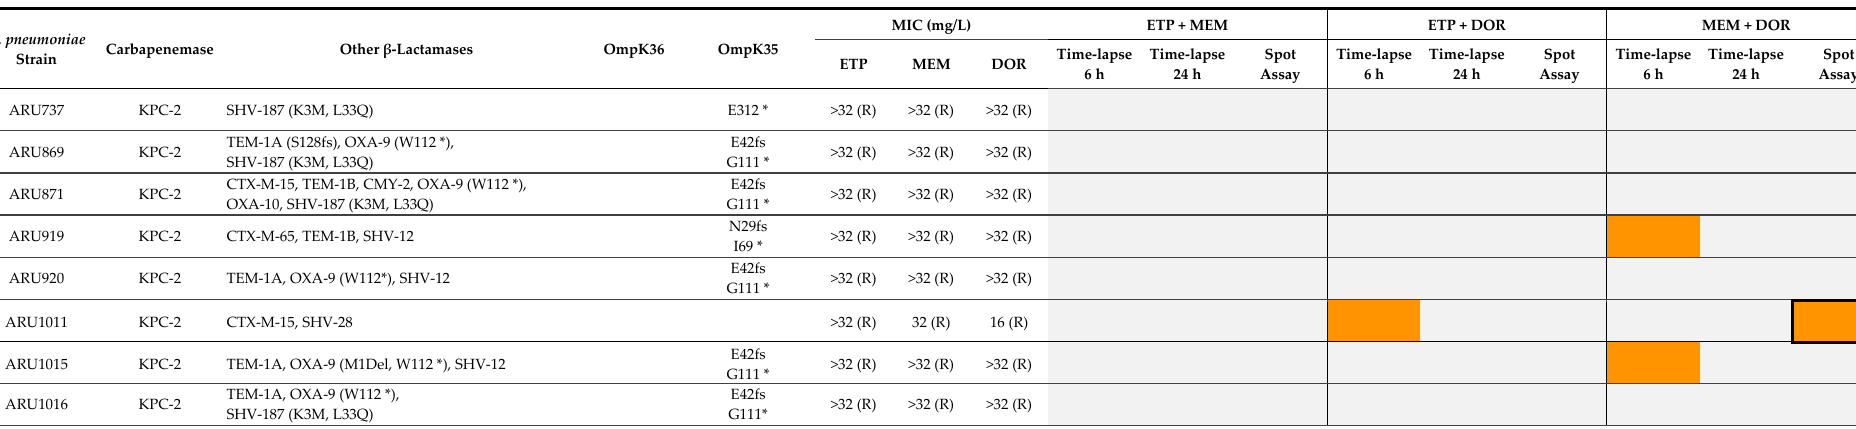
Table 2. Summary of results from time-lapse microscopy experiments (6 and 24 h) and spot assay (24 h) for double-carbapenem combinations against clinical carbapenemase-producing K. pneumoniae . MIC values for ertapenem, meropenem, and doripenem are classified according to EUCAST clinical breakpoints, version